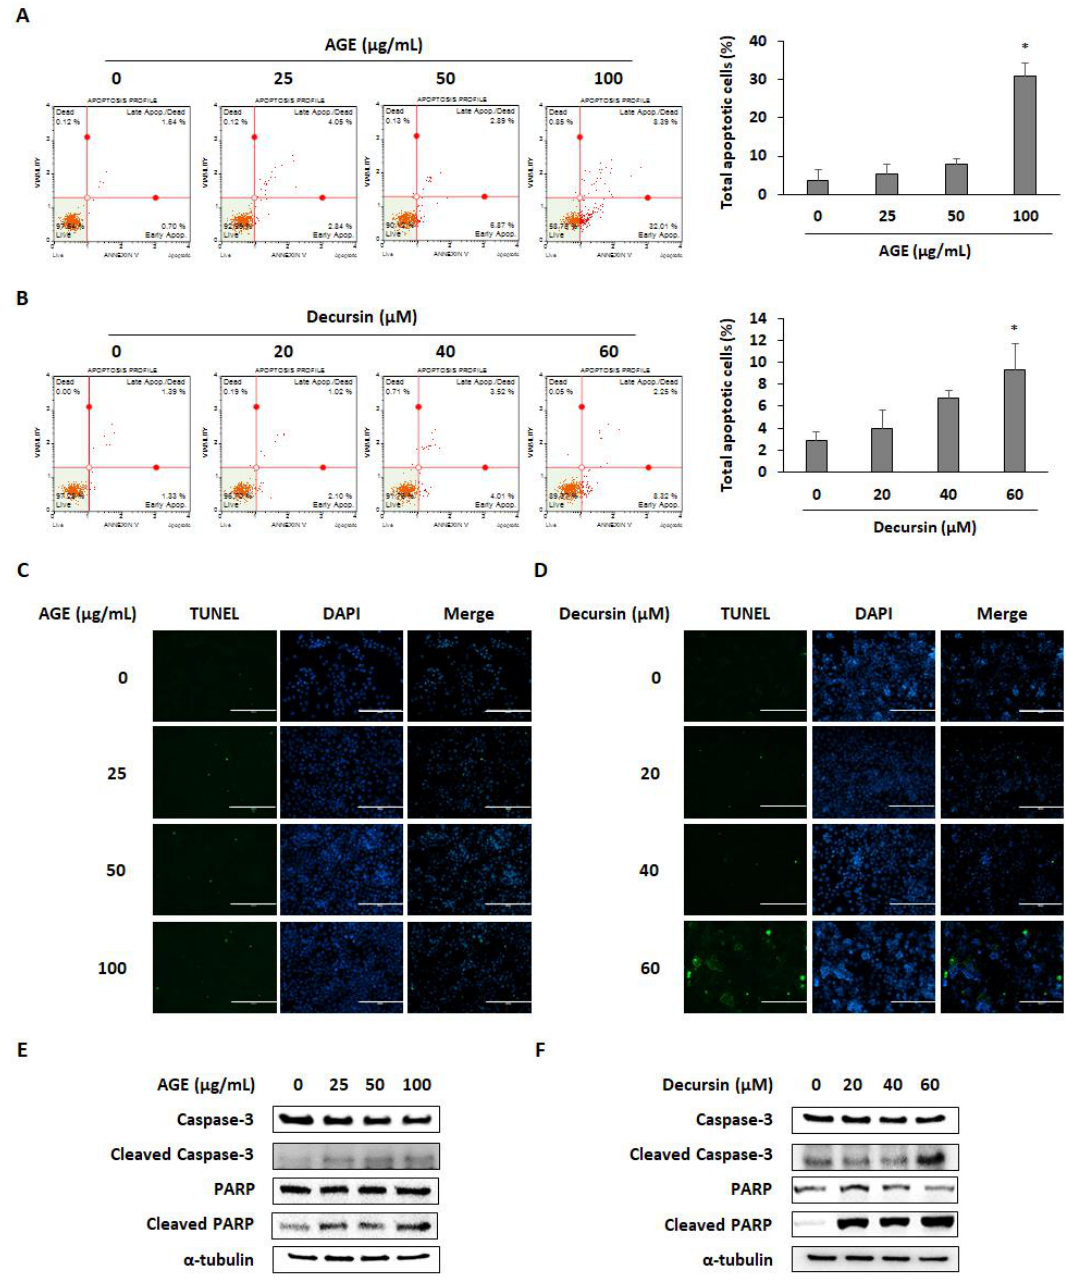
Figure 4. AGE and decursin induced apoptosis of pancreatic cancer cells. ( A , B ) The percentage of apoptotic cells after AGE ( A ) and decursin ( B ) treatment was detected by annexin V assay. ( C , D ) Terminal deoxynucleotidyl transferase dUTP nick-end labeling (TUNEL)-positive cells were captured by microscopic observation using AGE ( C )- and decursin ( D )-treated PANC-1 cells. ( E , F ) Protein expression of caspase-3, cleaved caspase-3, PARP, and cleaved PARP was detected in AGE ( E )- and decursin ( F )-treated PANC-1 cells. Data were analyzed from at least three independent experiments. * p < 0.05.